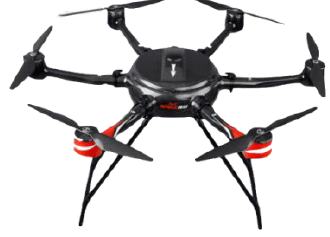
Figure 2. The overall view of the maritime unmanned aerial vehicle (Mar-UAV).